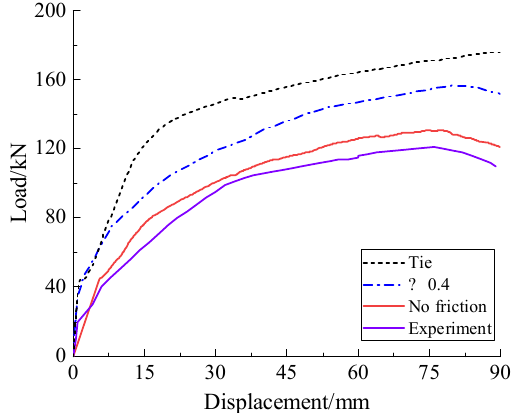
Figure 11. Load-deflection curves of three models and